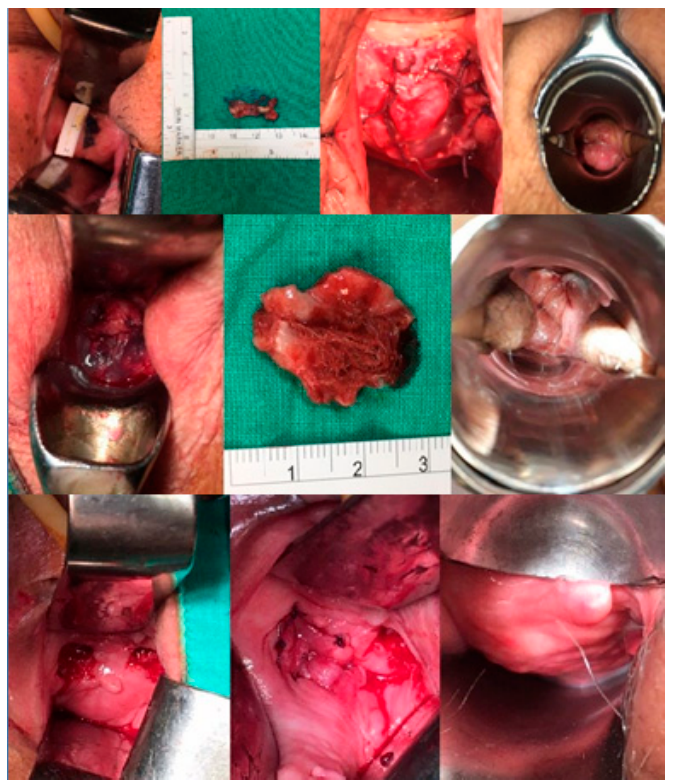
Figure 2. Amniotic graft inlay and wound healing of the patients.